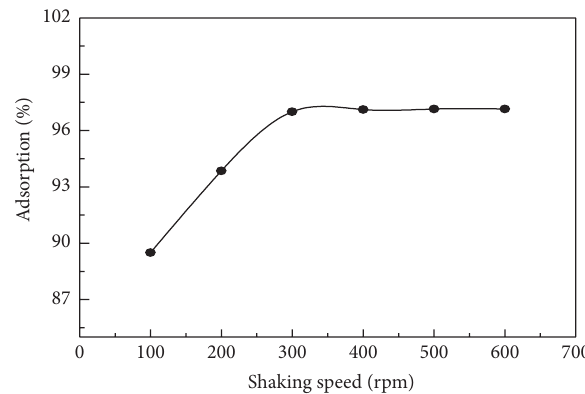
Figure 6: Effect of shaking speed on adsorption of MB on C. polygonoides ash.